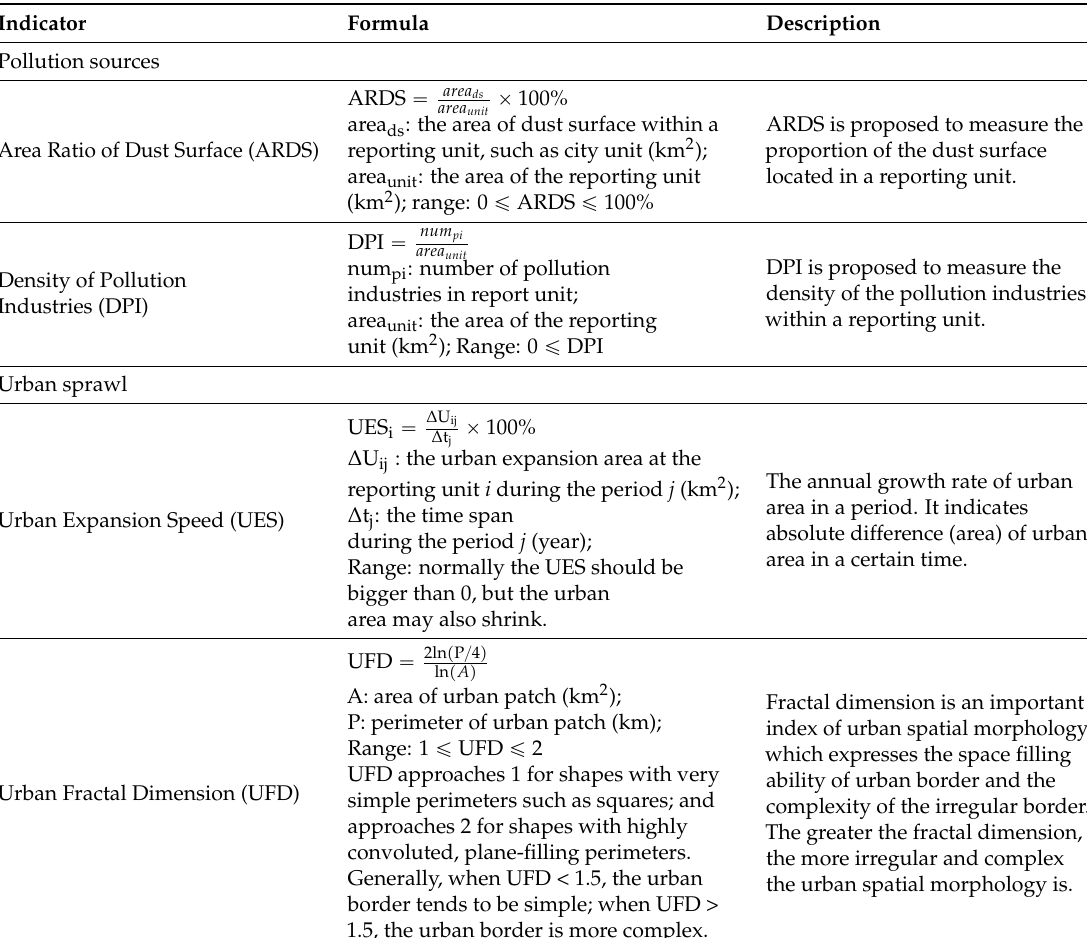
Table 1. Thematic monitoring indicators used in BTH